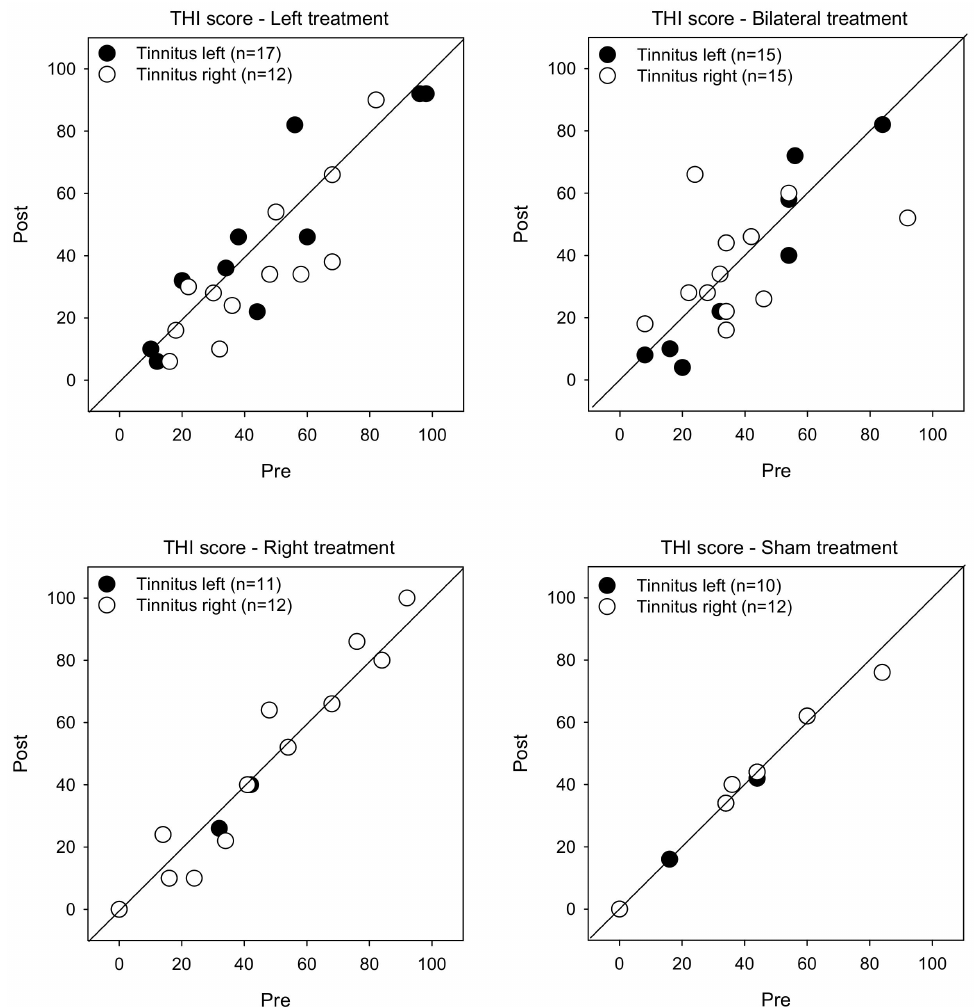
Figure 2. Post-treatment THI scores as a function of pre-treatment scores for the Left, Right, Bi- lateral and Sham treatment groups. The filled and open symbols show data for patients with left- or right-sided tinnitus, respectively. Values below the diagonal line indicate reduced THI scores after